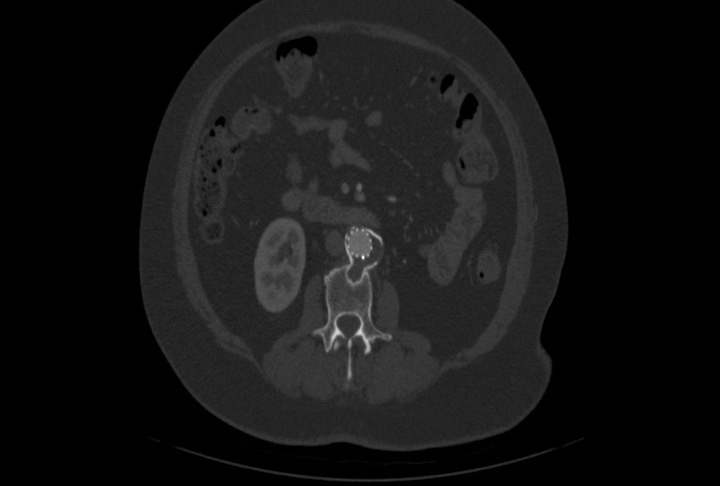
Postoperative axial angiotomography showing endoprosthesis within the aneurysm sac, excluding it, with no evidence of endoleaks.